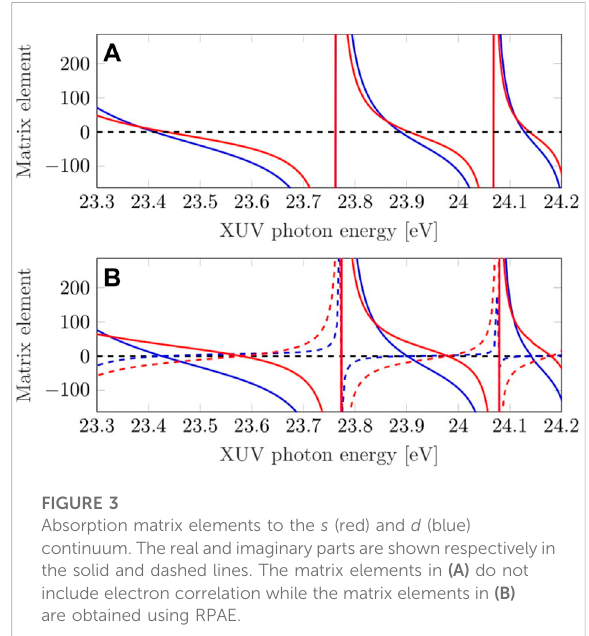
Absorption matrix elements to the s (red) and d (blue) continuum. The real and imaginary parts are shown respectively in the solid and dashed lines. The matrix elements in (A) do not include electron correlation while the matrix elements in (B) are obtained using